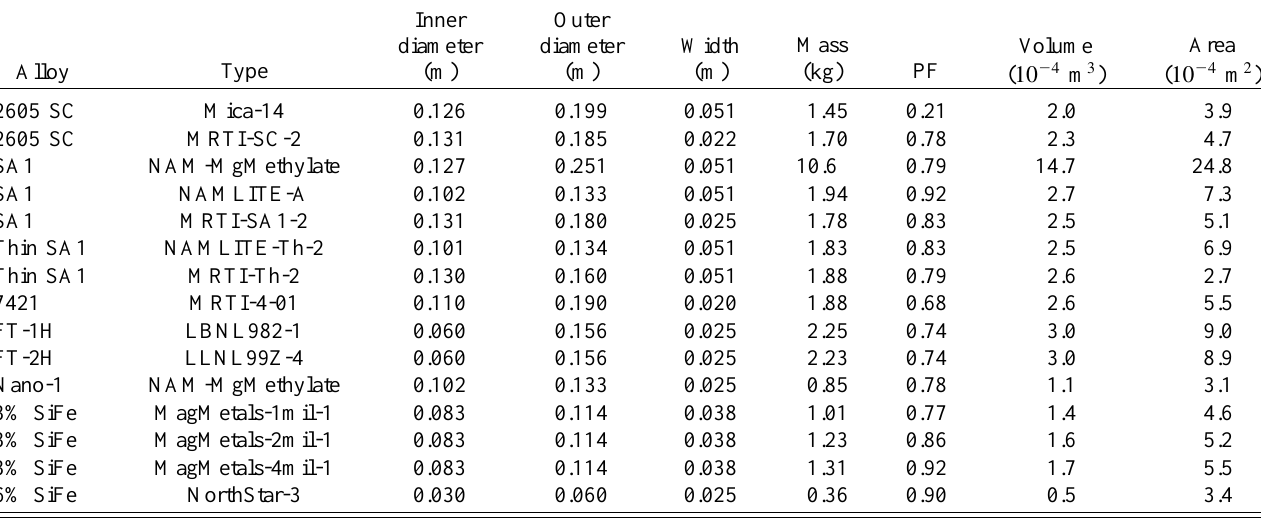
TABLE I. Mechanical specifications of each type of core tested. PF is the packing